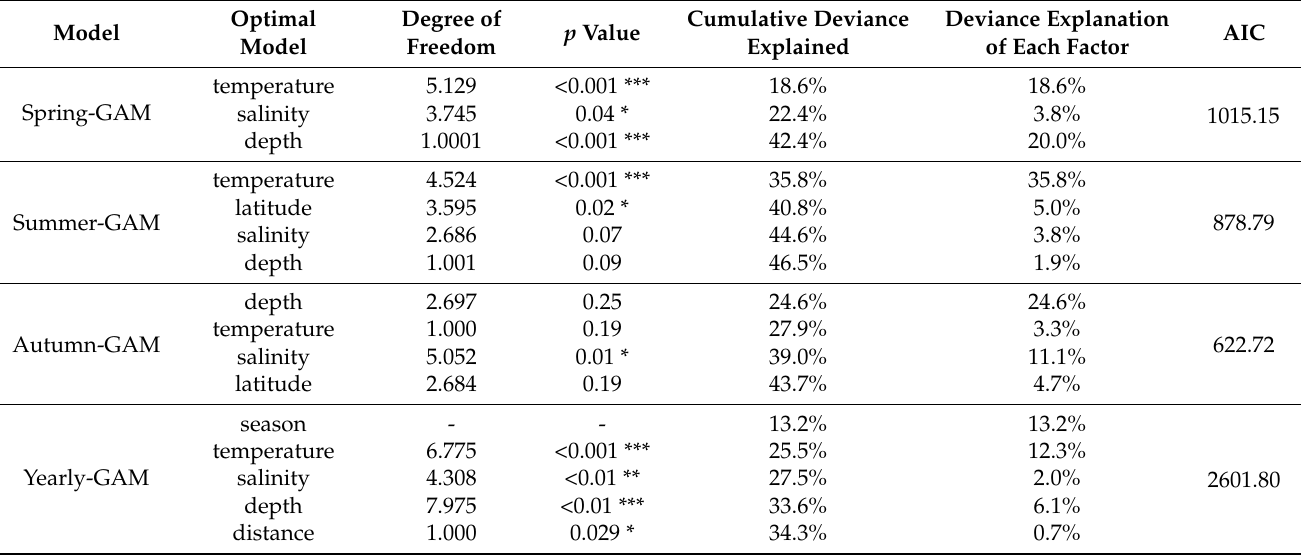
Table 2. Parameters of each factor in the optimal GAM model for each